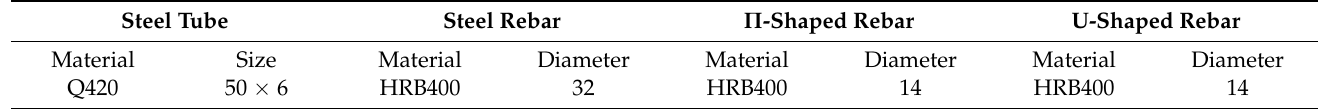
Table 4. The specific types of steel materials in numerical simulation (Unit: mm).